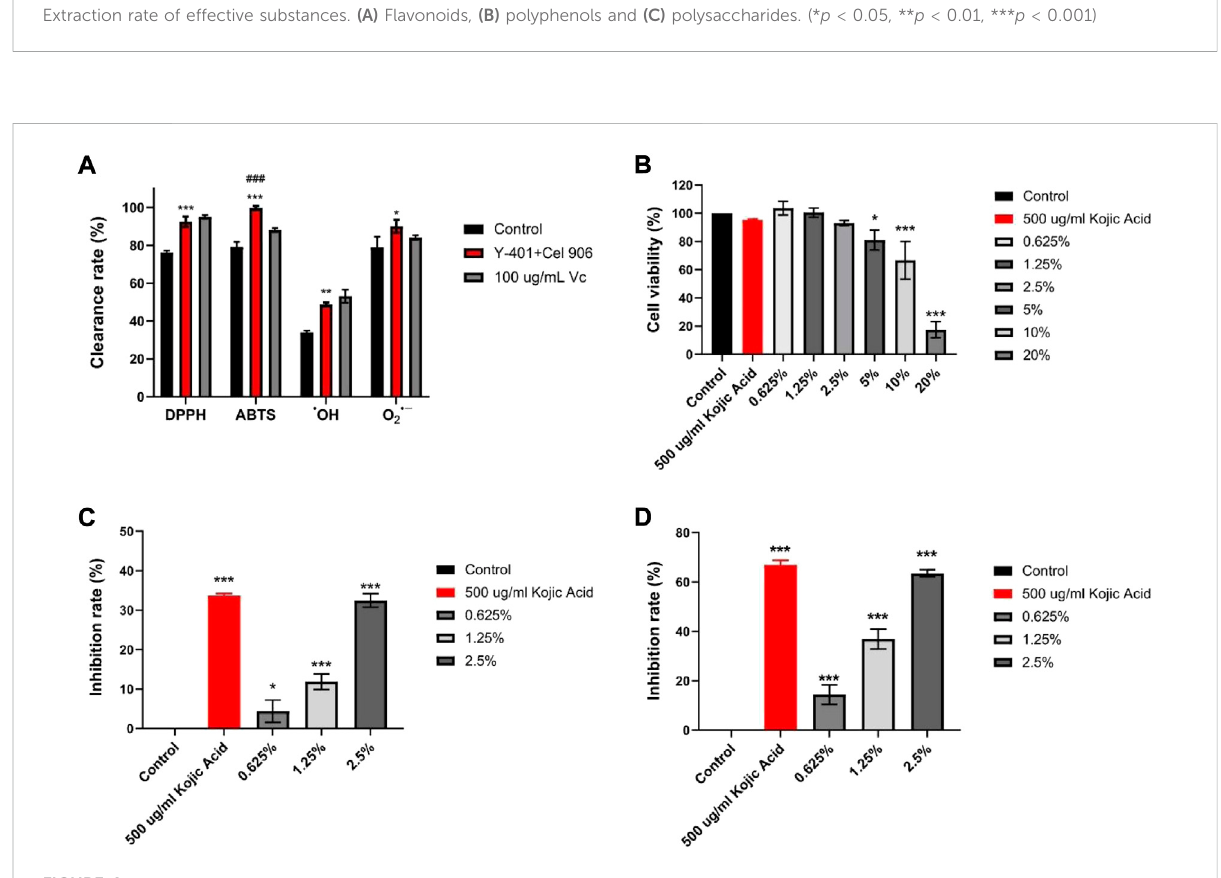
Inhibition of melanin production experiments. (A) Statistical chart of DPPH, ABTS, OH-, O2- free radical scavenging ability, (B) B16-F10 melanoma cell viability (C) Tyrosinase inhibition rate, (D) melanin synthesis inhibition rate (* p < 0.05, ** p < 0.01, *** p < 0.001 vs Control group. ### p < 0.001 vs 100 ug/mL Vc